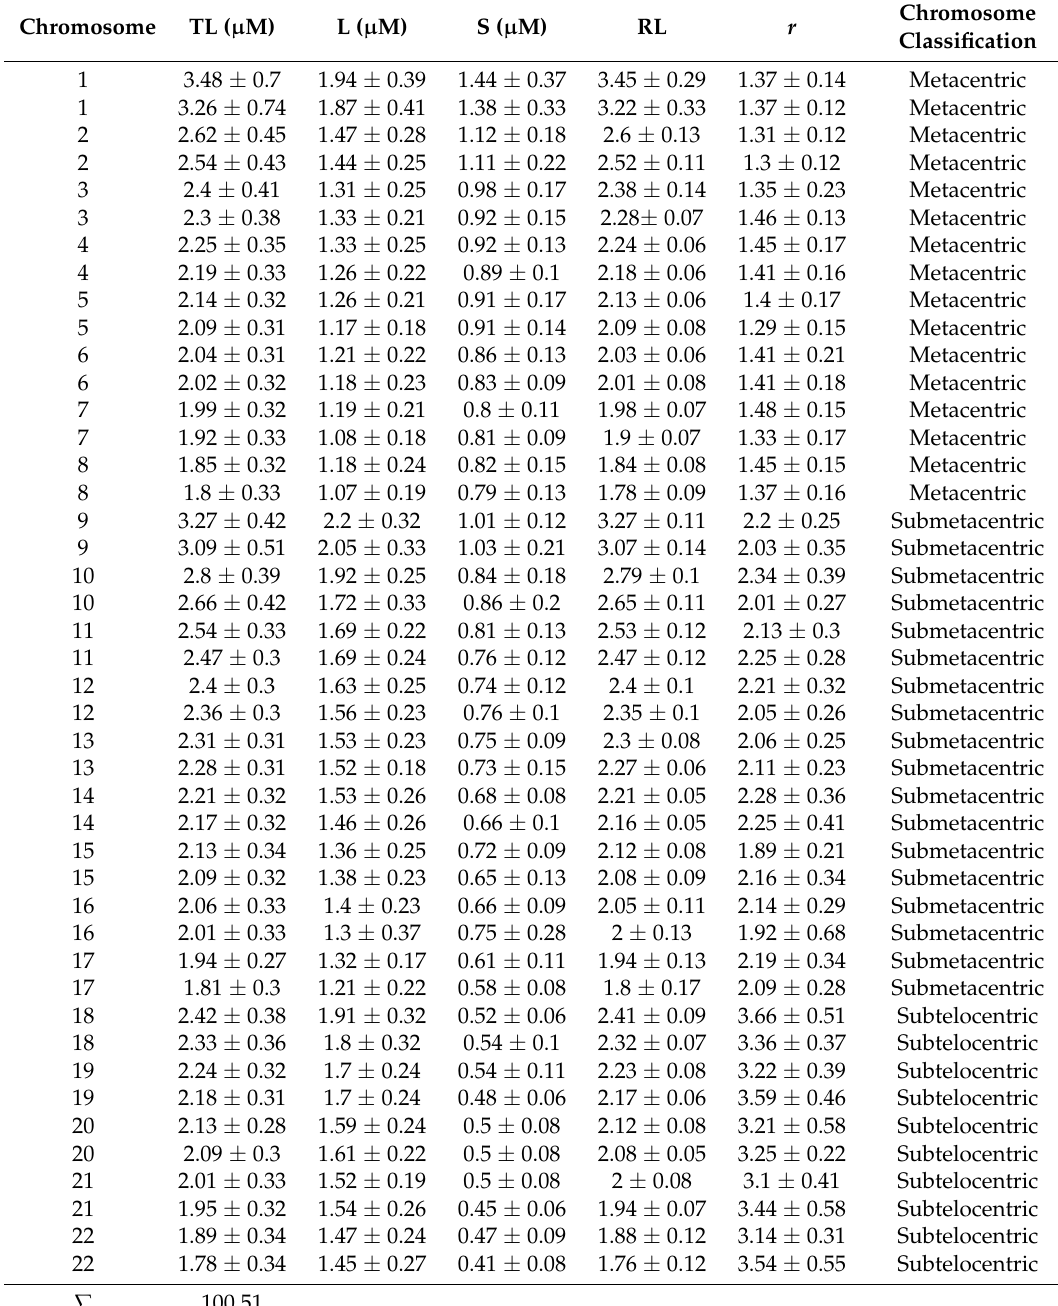
Table 1. Karymorphometrical analyses of Cephalotes pusilus (Klug, 1824). TL: total length; L: long arm length; S: short arm length; RL: relative length; r : arm ratio (=